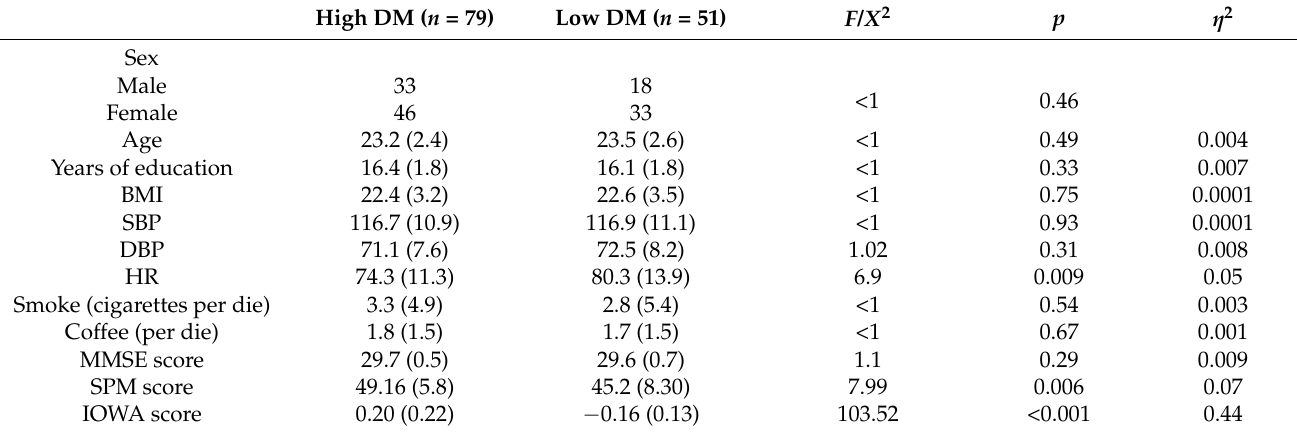
Table 1. Means (M) and standard deviations (SD) of the demographics and clinical and cognitive characteristics of the two groups of